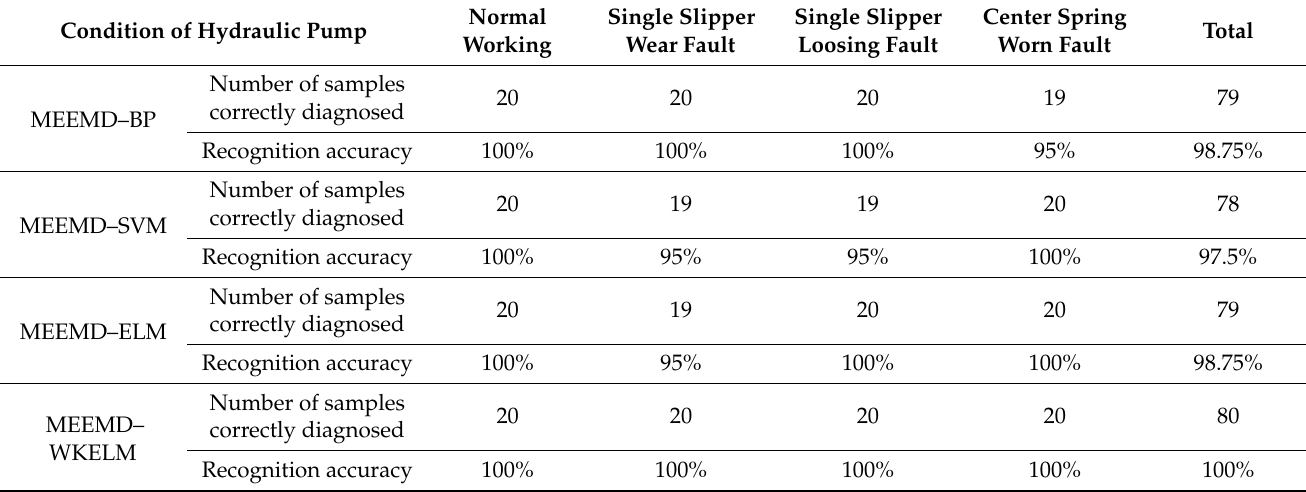
Table 5. Comparison of diagnostic accuracy of four fault diagnosis methods.